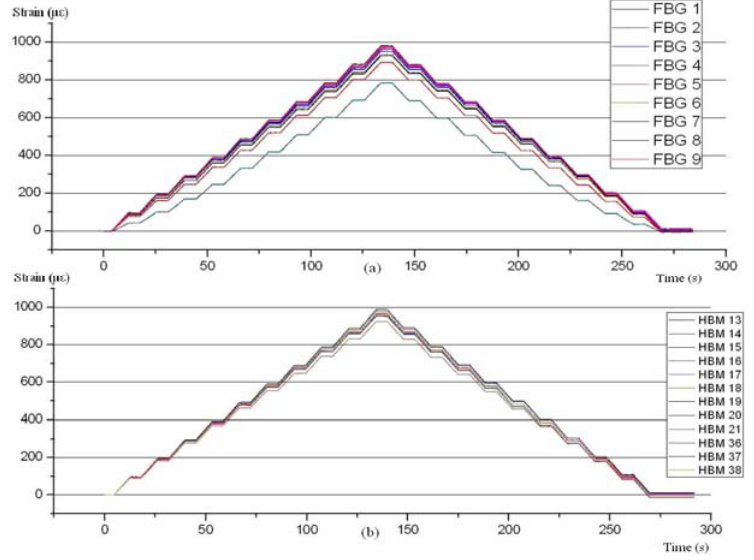
Figure 10. Specimen 2. Test before aging. 200 kN Traction stress. FBG (a) and strain gauges (b) .